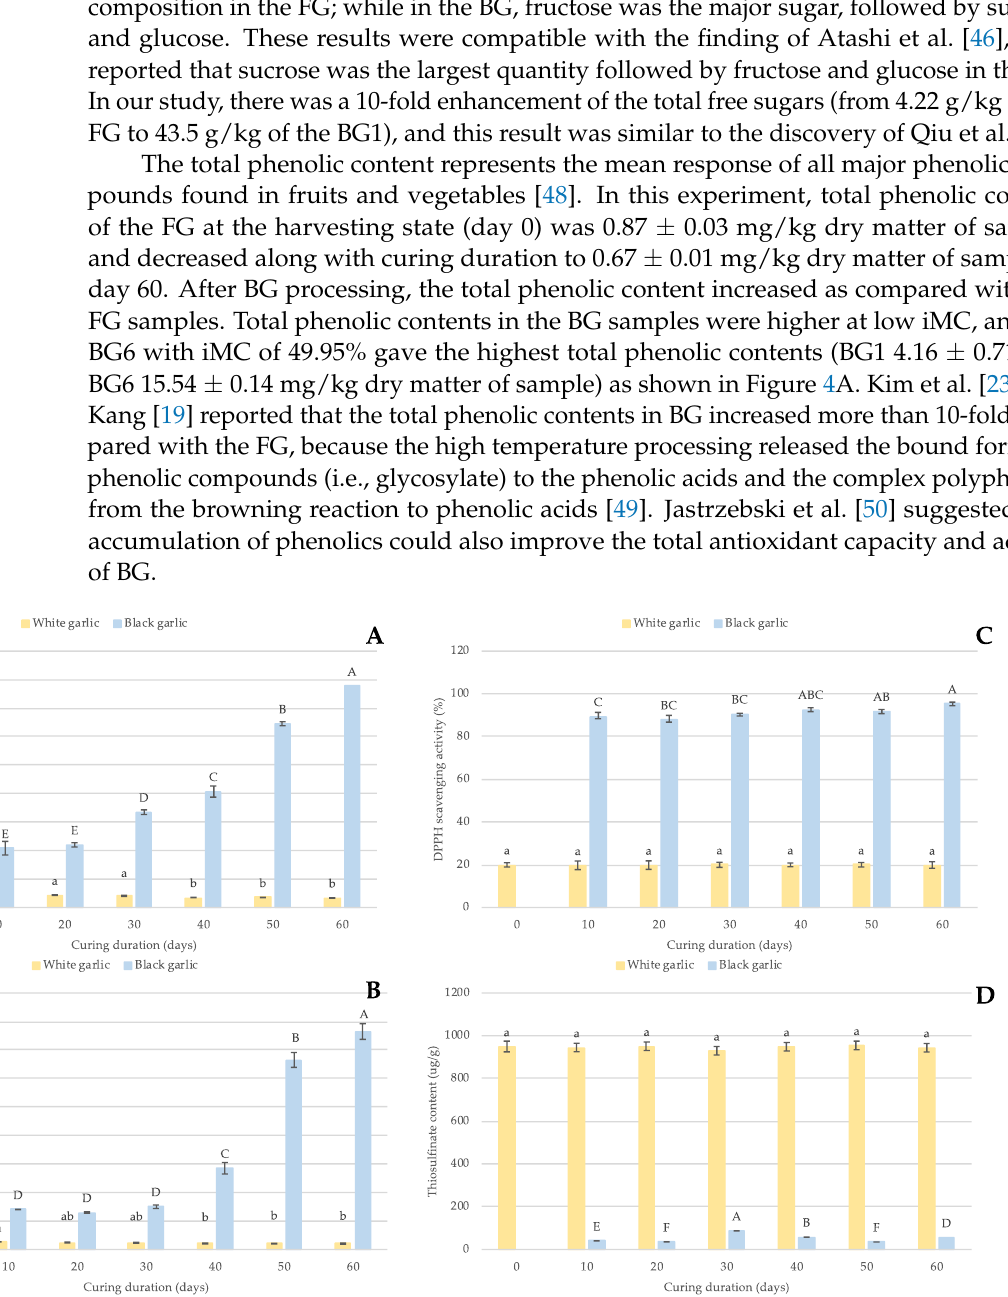
Figure 4. The chemical analysis of fresh garlic and black garlic samples at different curing durations. The different letter on the top of the bar is significantly different ( p < 0.05) by DMRT; the comparison is within two groups of samples (yellow bar represents FG and blue bar represents BG); the initial moisture content of FG was 72.60%, 66.78%, 59.99%, 56.44% 51.15% and 49.95% in 0, 10, 20, 30, 40, 50 and 60 days of cured process, respectively. Bars indicated the mean of five replicates with standard error. ( A ) Total phenolic content; ( B ) total flavonoid content; ( C ) DPPH scavenging activity; ( D ) thiosulfinate content.